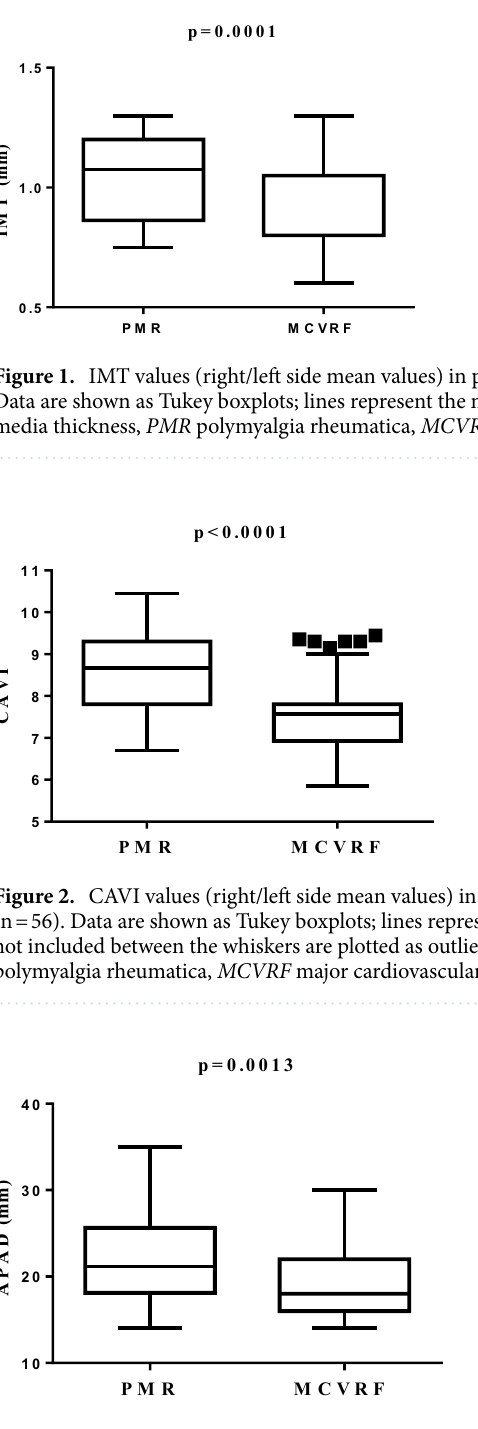
Figure 3. APAD values in patients with PMR (n = 48) and MCVRF controls (n = 56). Data are shown as Tukey boxplots; lines represent the median level with 25th–75th percentile. APAD anterior–posterior abdominal aortic diameter, PMR polymyalgia rheumatica, MCVRF major cardiovascular risk